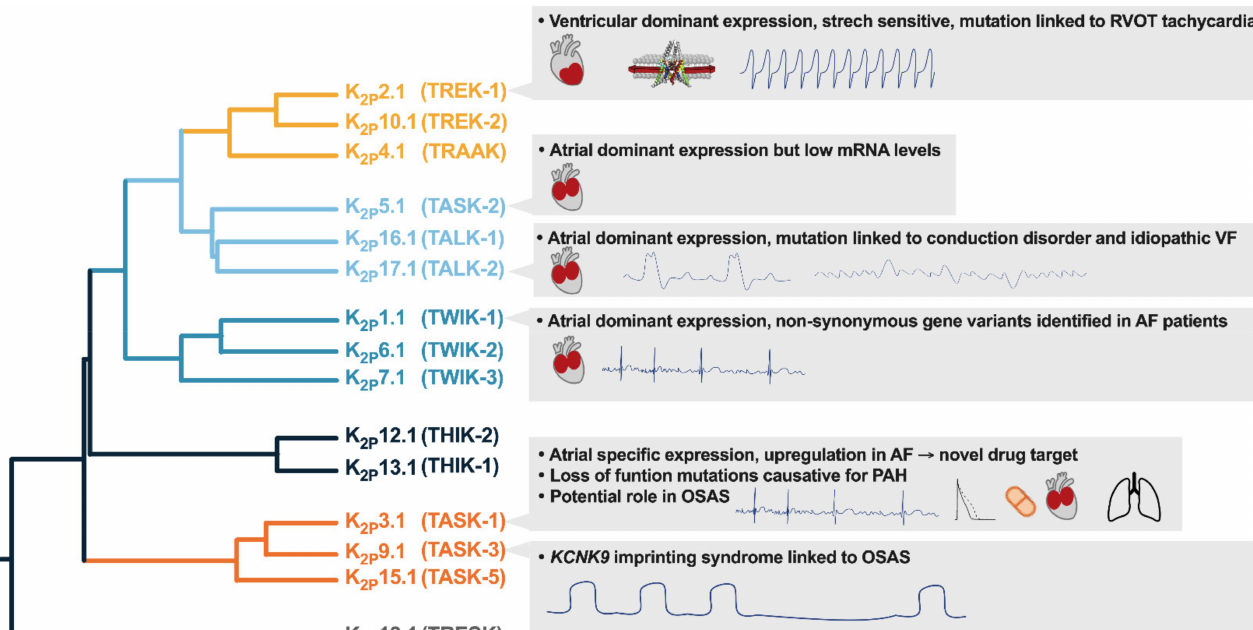
Figure 3. Potential translational implications of cardiac K2P channel expression.AF, atrial fibrillation; OSAS, obstructive sleep apnea; PAH pulmonary arterial hypertension; RVOT, right ventricular outflow tract; VF, ventricular